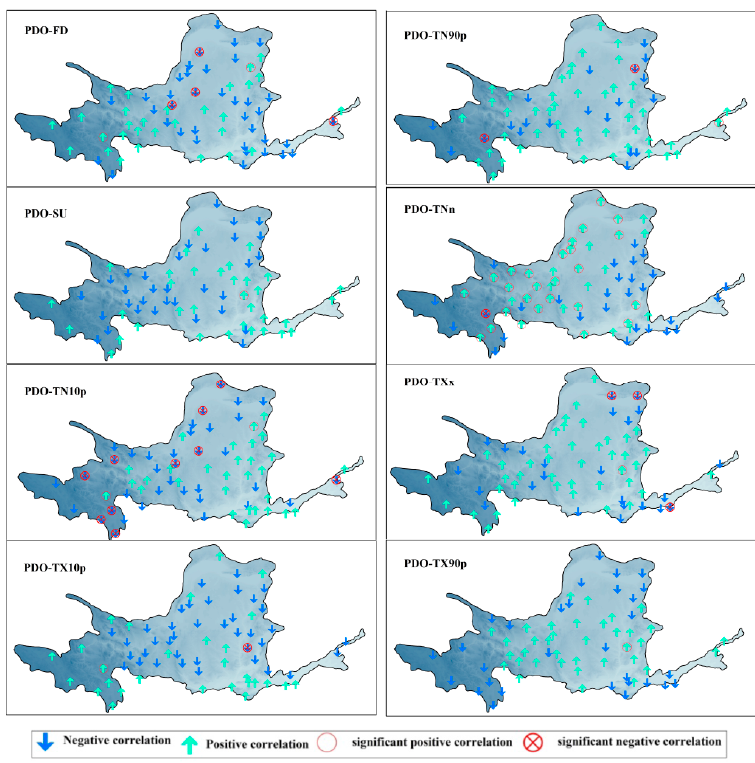
Figure 7. The potential connection between temperature extremes and the Pacific Decadal Oscillation (PDO).